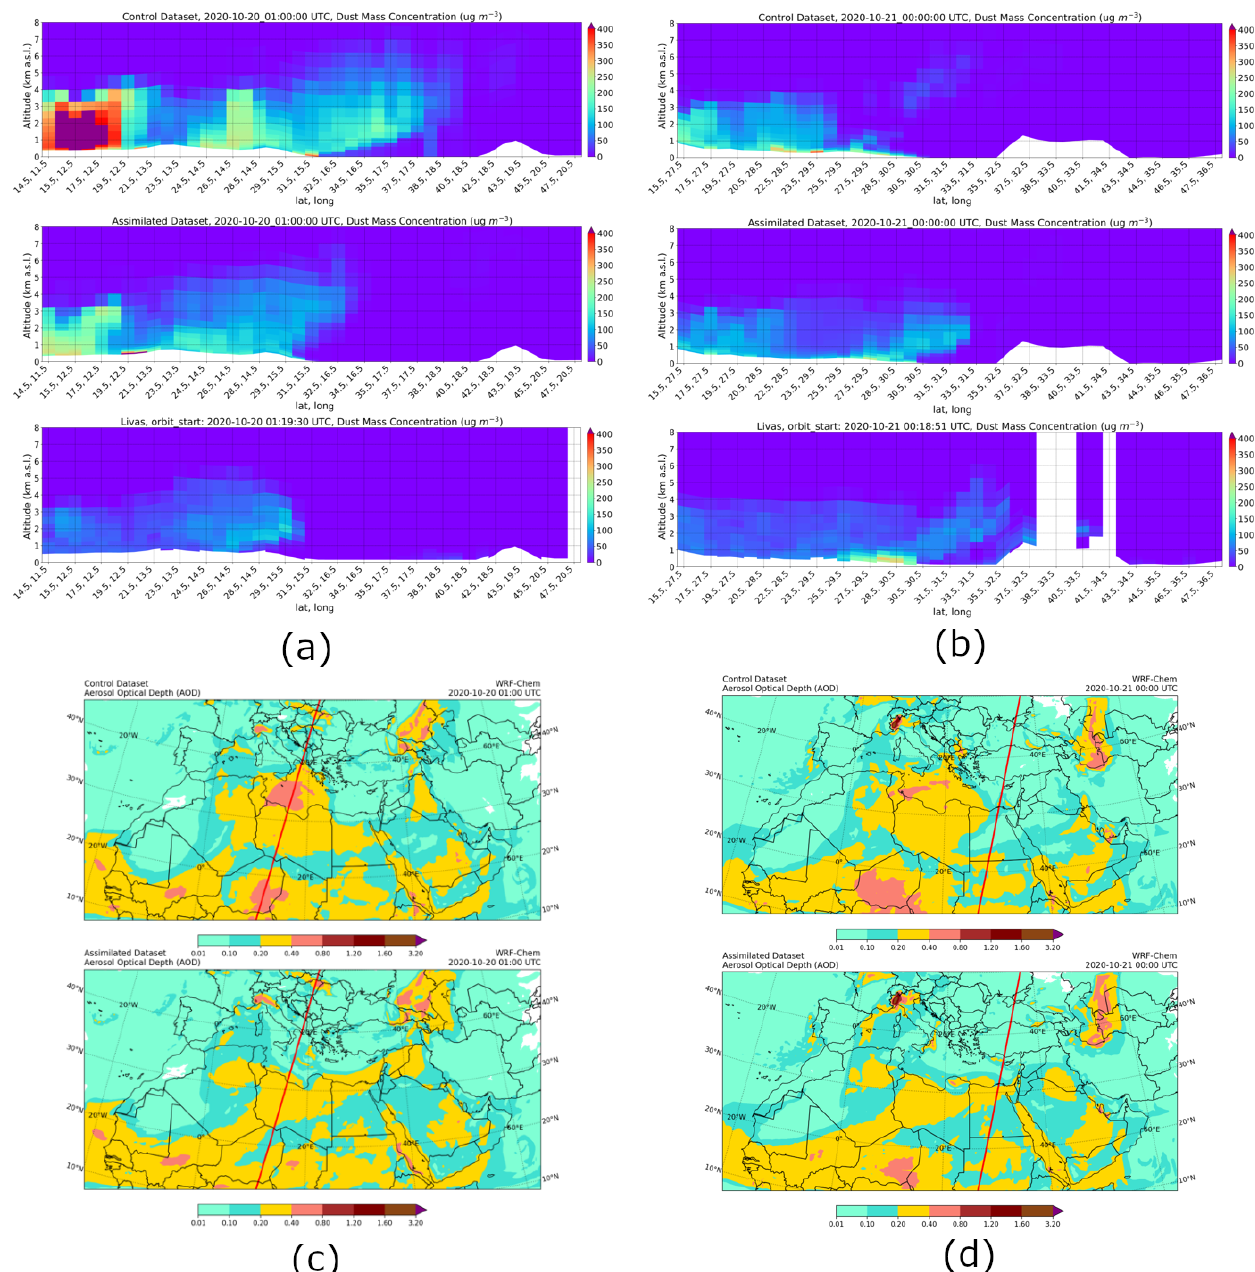
Figure 9. Collocated control and assimilated model runs of LIVAS depicting vertical dust concentrations for 20 October 2020 at 01:00 (a) and 21 October 2020 at 00:00 (b) . The CALIPSO tracks are represented by the red lines in the horizontal simulated AOD values (c, d) , where for (a) and (b) the top panel represents the control run, the middle panel the assimilated run and the bottom panel the LIVAS